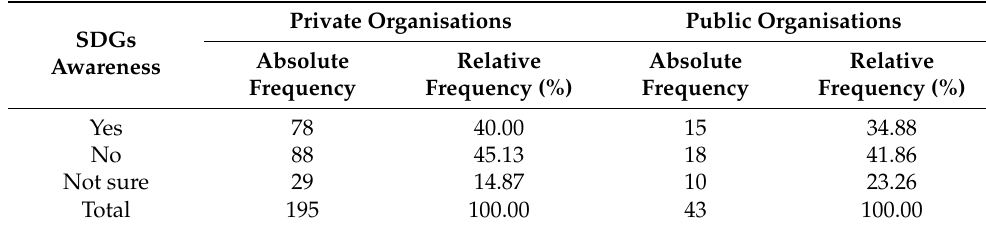
Table 4. The data comparison about awareness of the SDGs, according to the sector (private or public) of the organisation (own elaboration,